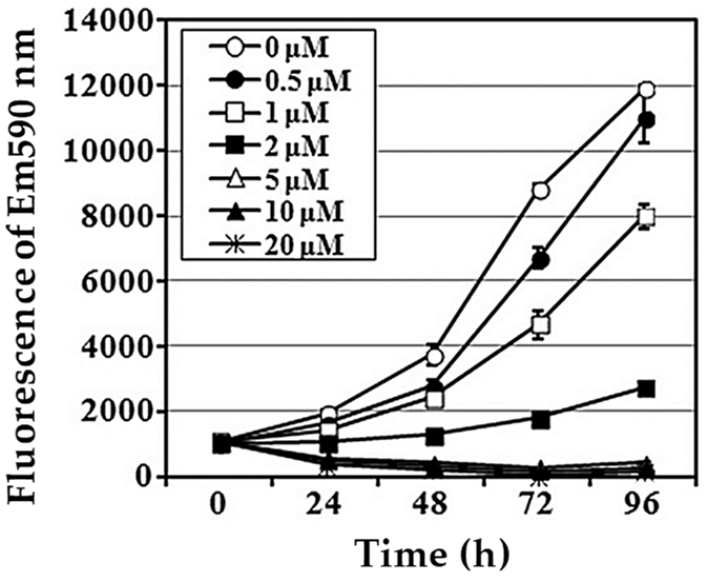
Figure 5. Inhibition of cell growth and induction of apoptosis after treating LN229 cell line with Phx-3. Source: Che et al. [70] by permission from Spandidos Publications Ltd.